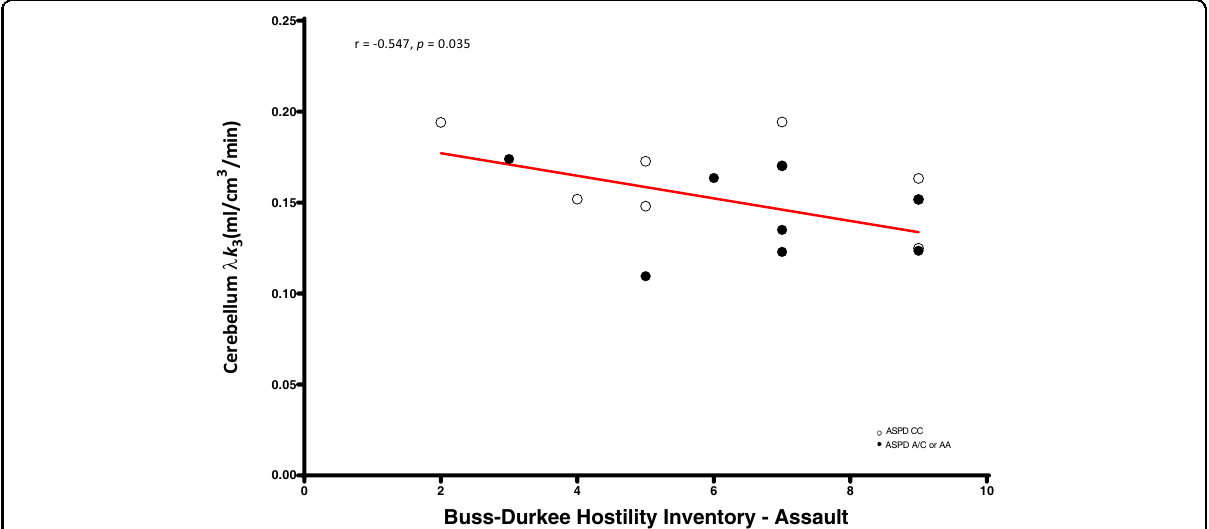
Fig. 5 Cerebellum fatty acid amide hydrolase λ k 3 is negatively correlated with Buss-Durkee Hostility Inventory — assault in antisocial personality disorder. After controlling for genotype, antisocial personality disorder participants with lower cerebellar fatty acid amide hydrolase density endorsed greater assaultive